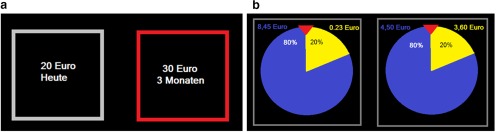
Screenshot of tasks. a, Intertemporal choice task. Participants chose between a smaller reward now or a larger reward later by pressing the E or I key. When the choice was made, the chosen option was highlighted by a red frame. b, Holt-Laury task: participants chose one of two gambles, one considered risky and one considered safer. Lotteries were depicted as wheels of fortune.